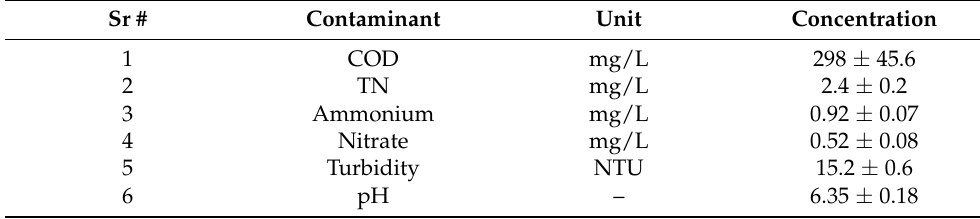
Table 1. Characteristics of the influent